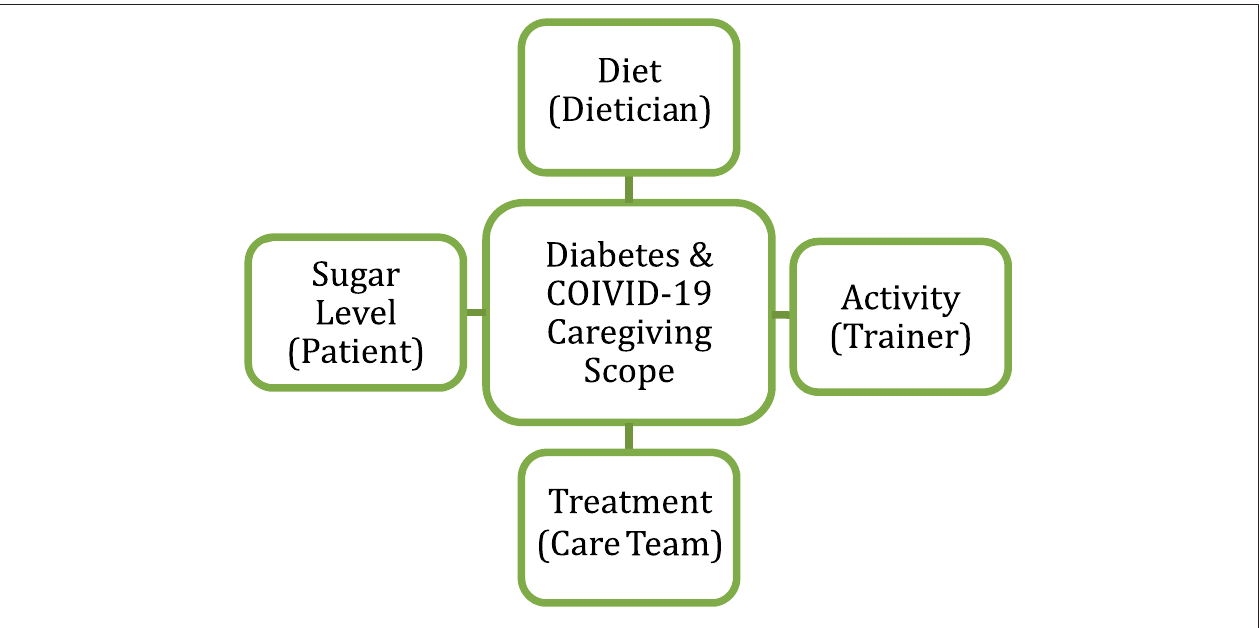
FIGURE 2 | Diabetes and COVID-19 caregiving